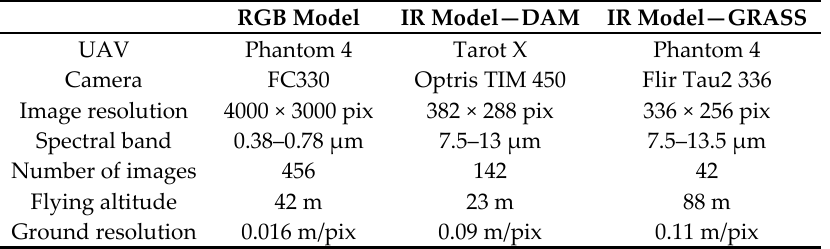
Table 1. Parameters of UAV survey for RGB and IR data.